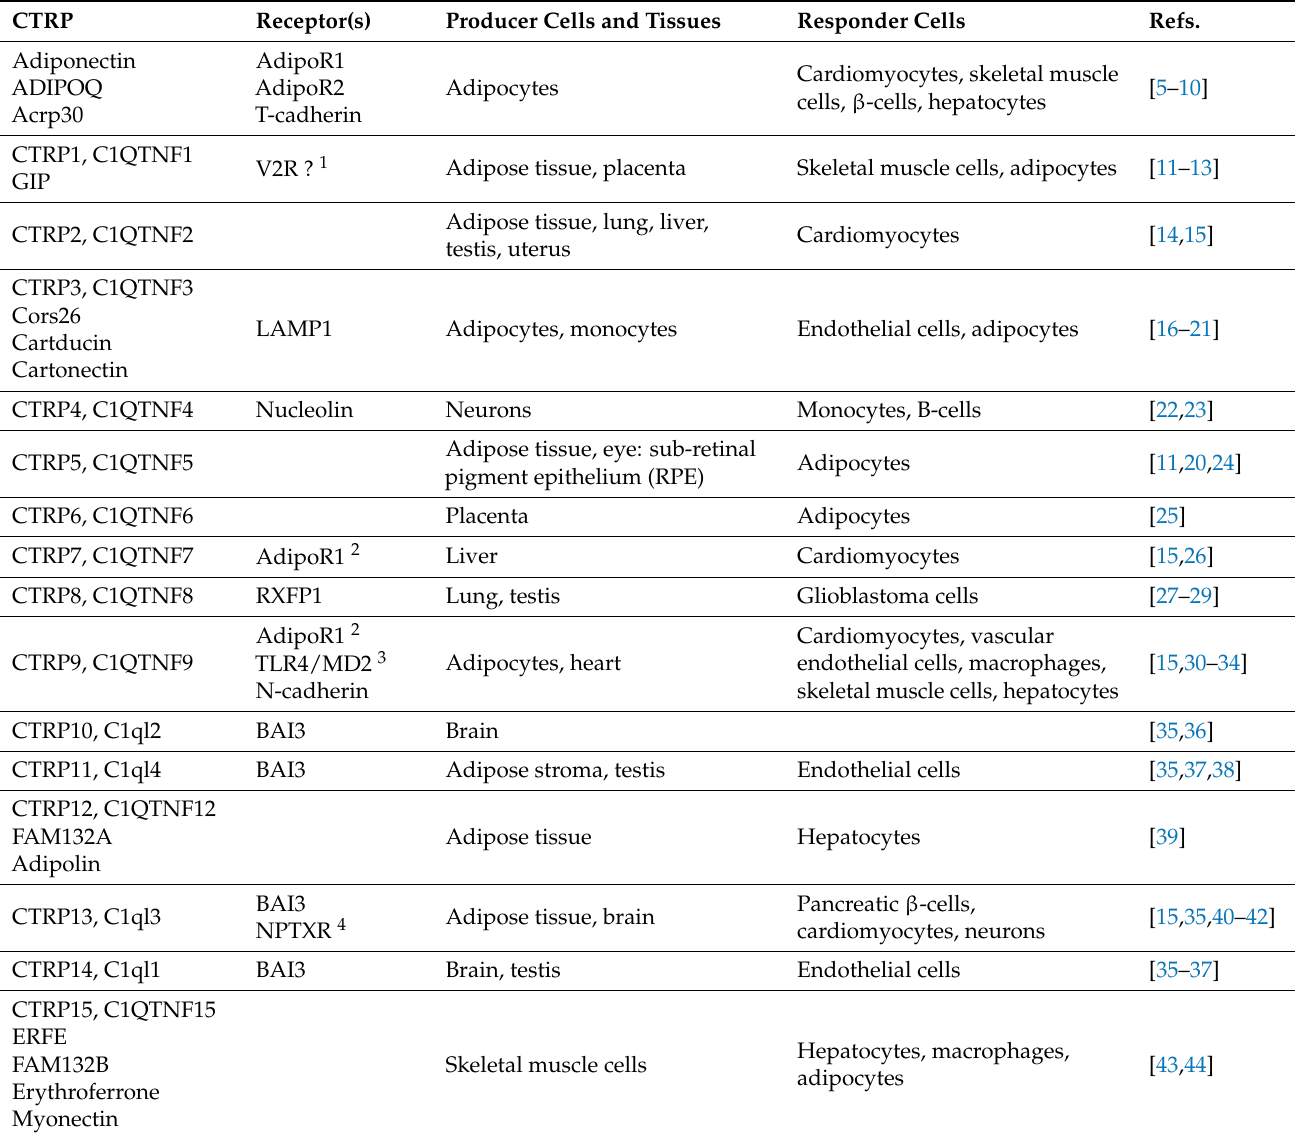
Table 1. The CTRP family: producing and responding cell